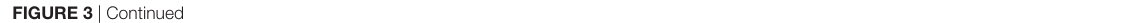
FigUre 3 | Continued Transmissible gastroenteritis virus nsp14 triggers IFN- β and NF- κ B activation. HEK-293T cells were cotransfected with pRL-TK plasmid and IFN- β -Luc (a) , IRF3-Luc (B) , or NF- κ B-Luc (c) luciferase reporter plasmids together with increasing doses (0.2, 0.4, 0.8 µg) of pCAGGS-HA-nsp14 or empty vector. Also, PK-15 cells were cotransfected with pRL-TK plasmid and IFN- β -Luc (D) , IRF3-Luc (e) , or NF- κ B-Luc (F) luciferase reporter plasmids together with increasing doses (0.2, 0.4, 0.8 µg) of pCAGGS-HA-nsp14 or empty vector. The cells lysates were harvested for dual luciferase assays at 30 h post-transfection. Values are the mean ± SD of three independent tests. ** P < 0.01 or *** P < 0.001 compared with empty vector group. (g) HEK-293T cells were transfected with increasing quantities (1, 2, 4 µg) of pCAGGS-HA-nsp14 or empty vector for 30 h, and then subjected to immunoblotting with antibodies specific for endogenous IRF3, phosphorylated IRF3 (p-IRF3), p65, or p-p65. Anti-HA mouse antibody was used to confirm the expression of nsp14. β -actin expression was used as a loading control. The ratio of phosphorylated/total p65 and phosphorylated/total IRF3 was analyzed using ImageJ Software. (h) PK-15 cells were cotransfected with plasmids encoding HA-tagged nsp14 protein or empty vector together with plasmids encoding EGFP-tagged p65 protein. Then, the cells were fixed and immunostained with anti-HA monoclonal antibodies (mAbs) to observe the nuclear translocation of overexpressed p65 using confocal microscopy. (i) HEK-293T cells were transfected with plasmids encoding HA-tagged nsp14 protein or empty vector. Then, the cells were fixed and immunostained with anti-p65 antibody to observe the nuclear translocation of endogenous p65 using confocal